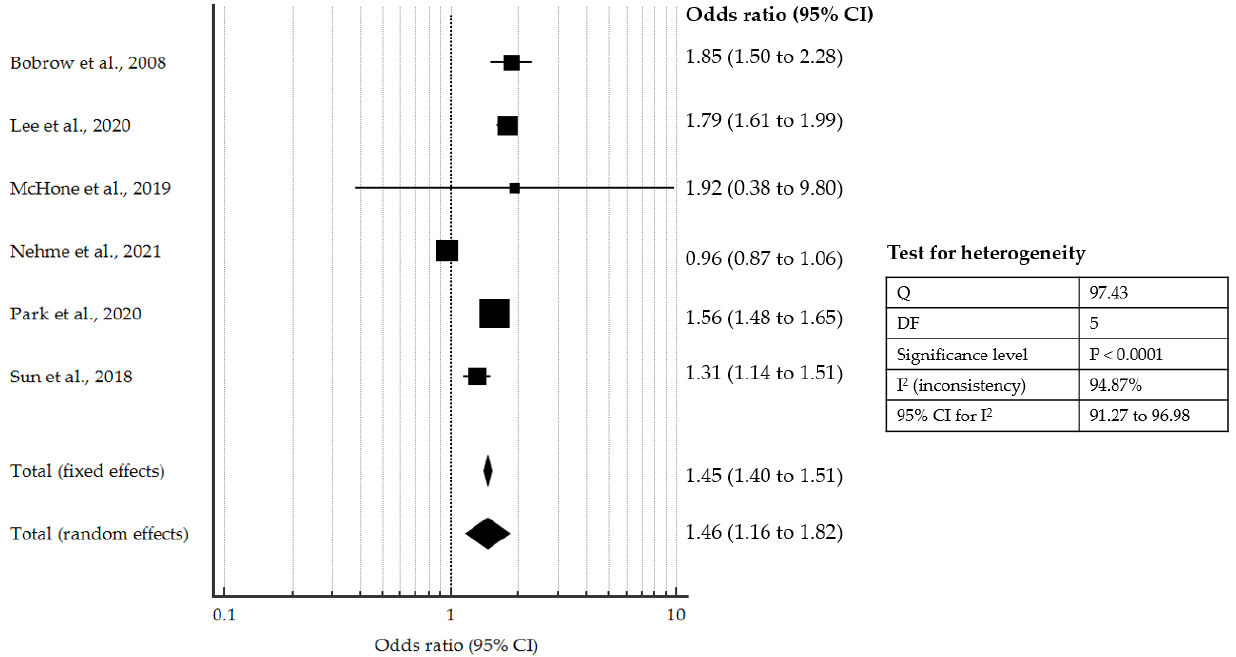
Figure 2. Forest plot showing pooled OR for survival-to-discharge with HP CPR or similar intervention compared to controls [12,14,16,20–22].